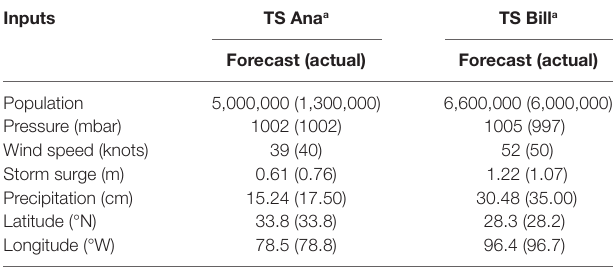
TaBle 3 | Input data for tropical storms (TS) Ana and Bill. inputs Ts ana